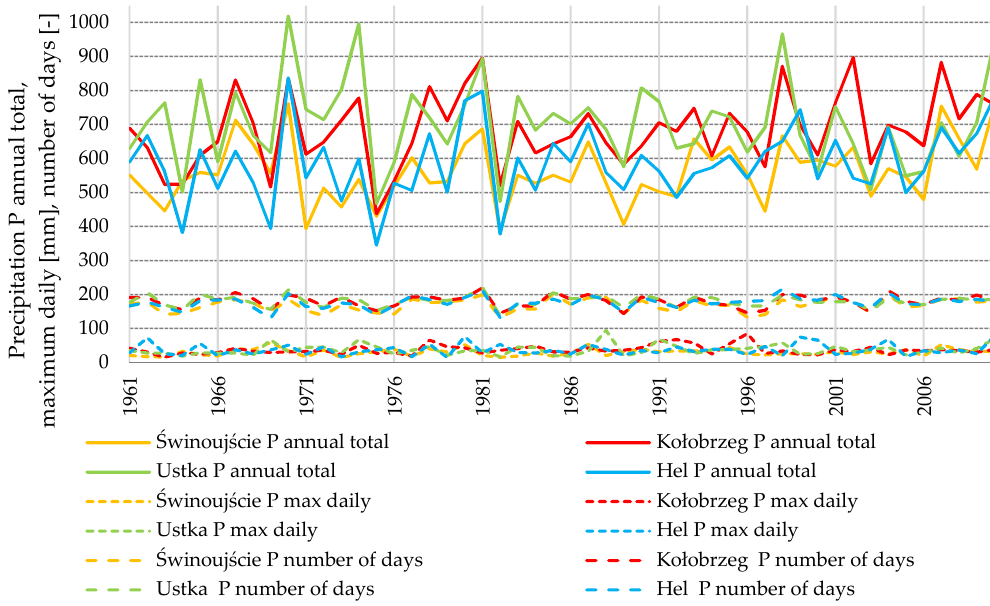
Figure 3. Annual dynamics of precipitation in the Polish Baltic coastal zone.